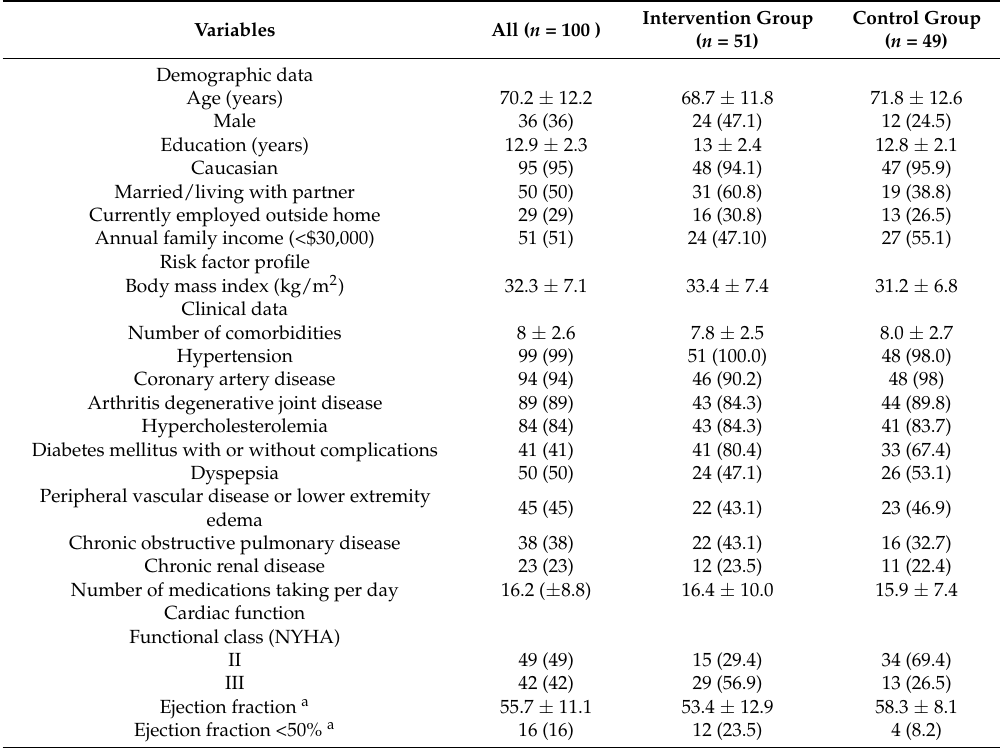
Table 1. Participants’ demographic and clinical